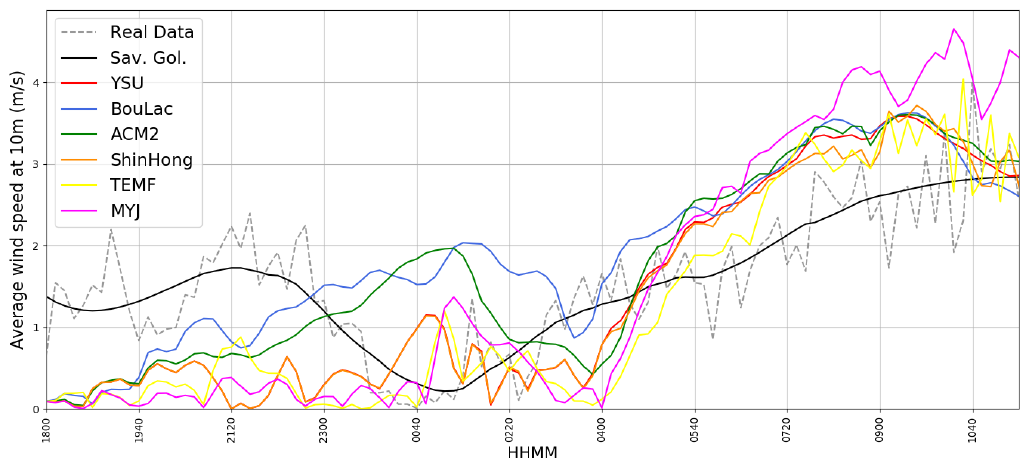
Figure 12 . Simulated U10M timeseries compared with real GL U10M timeseries, 17/05/2017, dotted grey: real data, black: Savitsky – Golay smoothing of real data, red: simulated data with YSU parametrization, blue: simulated data with BouLac parametrization, green: simulated data with ACM2 parametrization, orange: simulated data with ShinHong parametrization, yellow: simulated data with TEMF parametrization, purple: simulated data with MYJ parametrization.